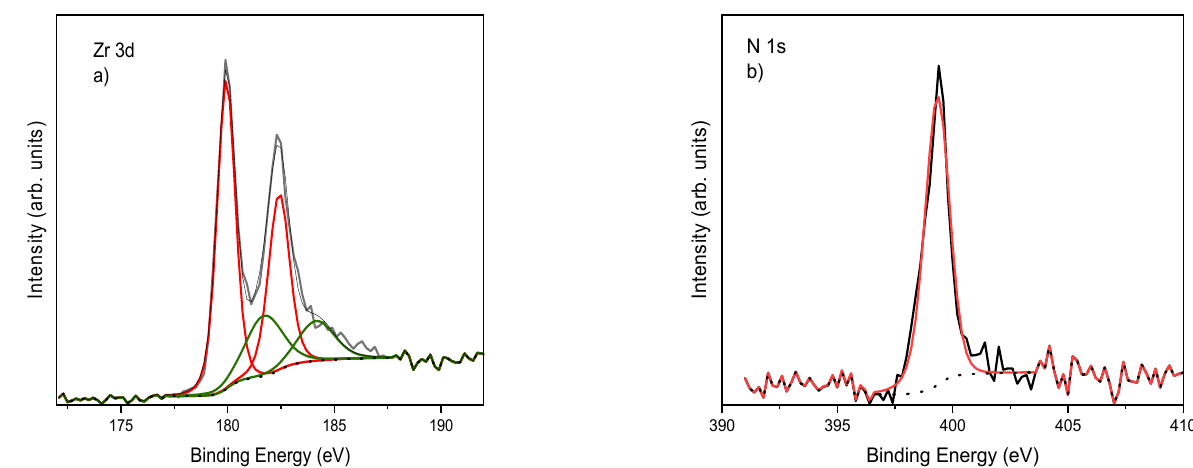
Figure 7. Zr 3d region ( a ) and N1s region ( b ) of sample ZrN D after peak fitting of level 2.